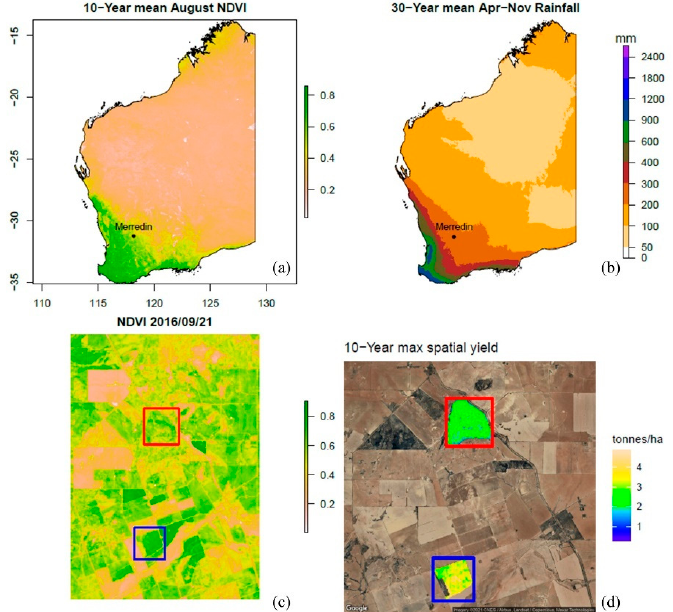
Figure 1. The study area: ( a ) The 10-year mean NDVI in August in Western Australia (WA) and study area location for Merredin (MODIS Terra, 2007–2016); ( b ) General growing season (Aril to November) rainfall distribution in WA (Australian Bureau of Meteorology, 1961–1990); ( c ) NDVI derived from Landsat 08 OLI in Merredin (21 September 2016) and location of the training field J (red box) and testing field M (blue box); ( d ) Maximum wheat yield across the two fields from 2003–2017. Table 1. Farming management and rainfall conditions for winter wheat in the two field sites dur- ing 2003 to 2017.